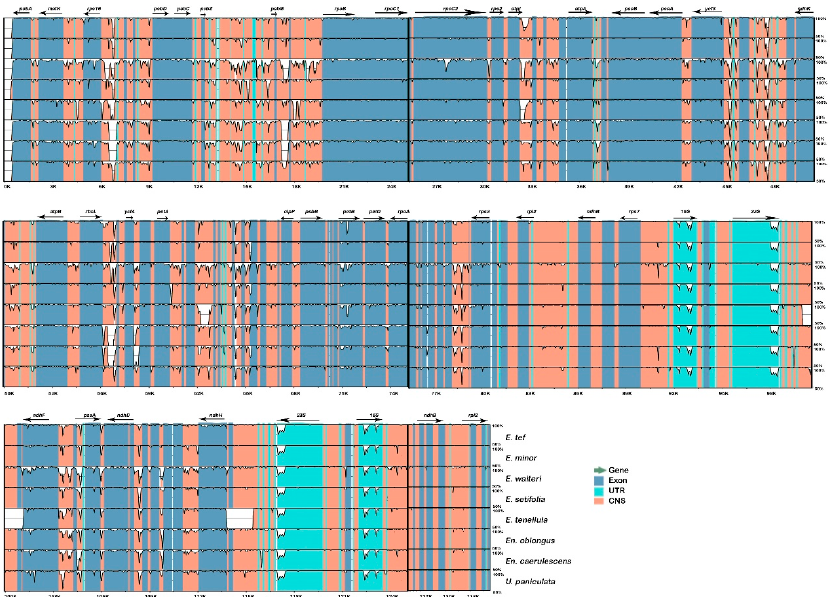
Figure 5. Sequence alignment plot comparing four cp genomes with E. pilosa as a reference. Genome regions are color coded as protein coding, rRNA coding, tRNA coding or conserved noncoding sequences. The vertical scale indicates the percentage identity, ranging from 50% to 100%.